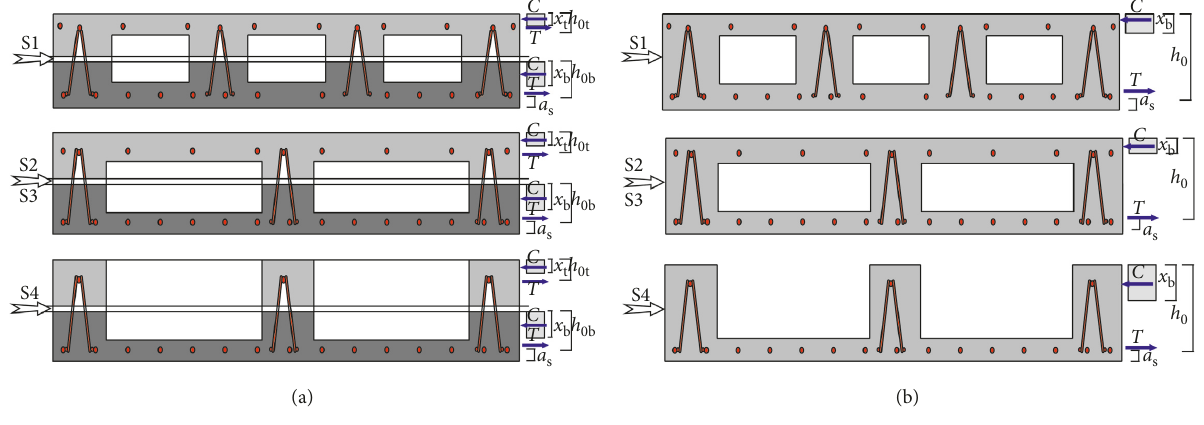
Figure 13: (a) Noncomposite state and (b) fully composite state. Table 7: Ultimate moment of fully composite state.